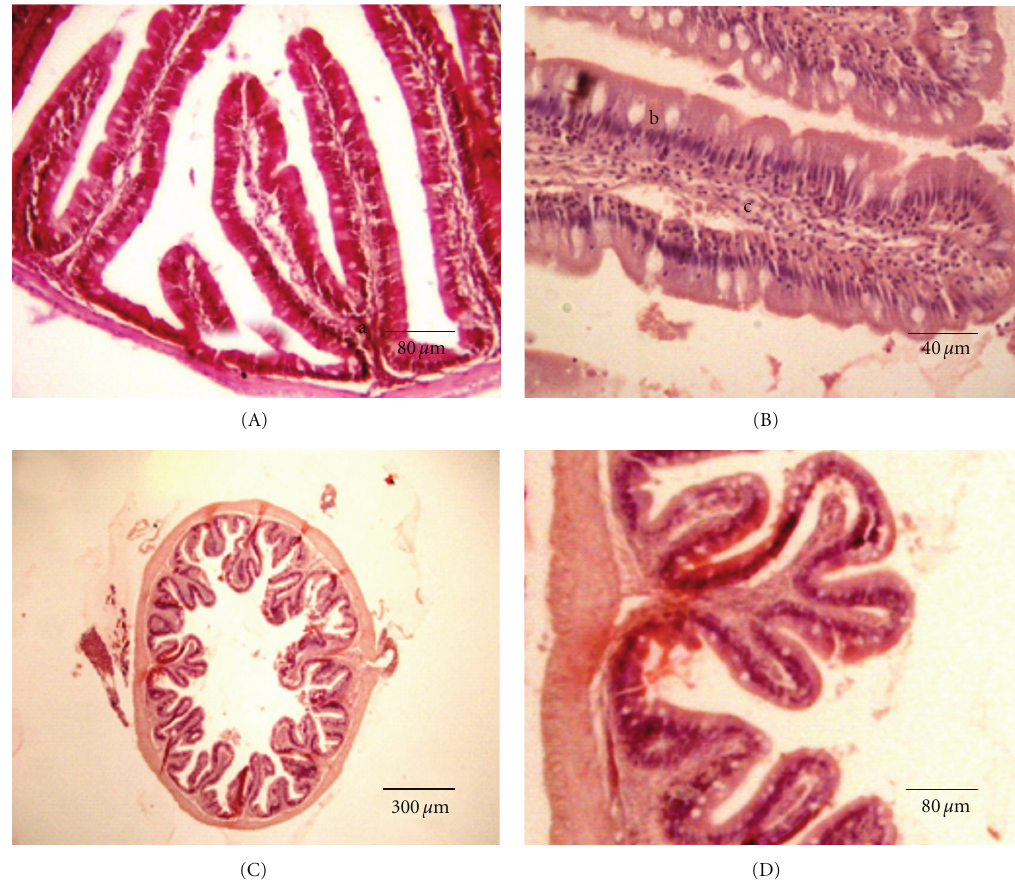
Figure 8: Intestine of S. fuscus . (A) Anterior intestinal mucosa, with ramified folds (a); (B) intestinal fold constituted by a simple cylindrical epithelium with goblet and absorptive cells (b) and lamina propria of conjunctive; (C) posterior intestine with mucosa showing short intestinal folds and (D) intestinal folds situated above the thick